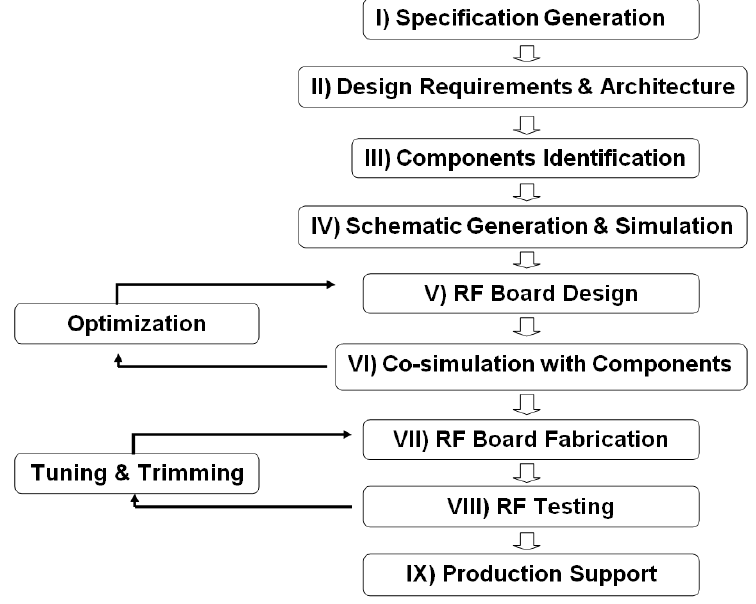
Figure 1. Standard RF circuit design